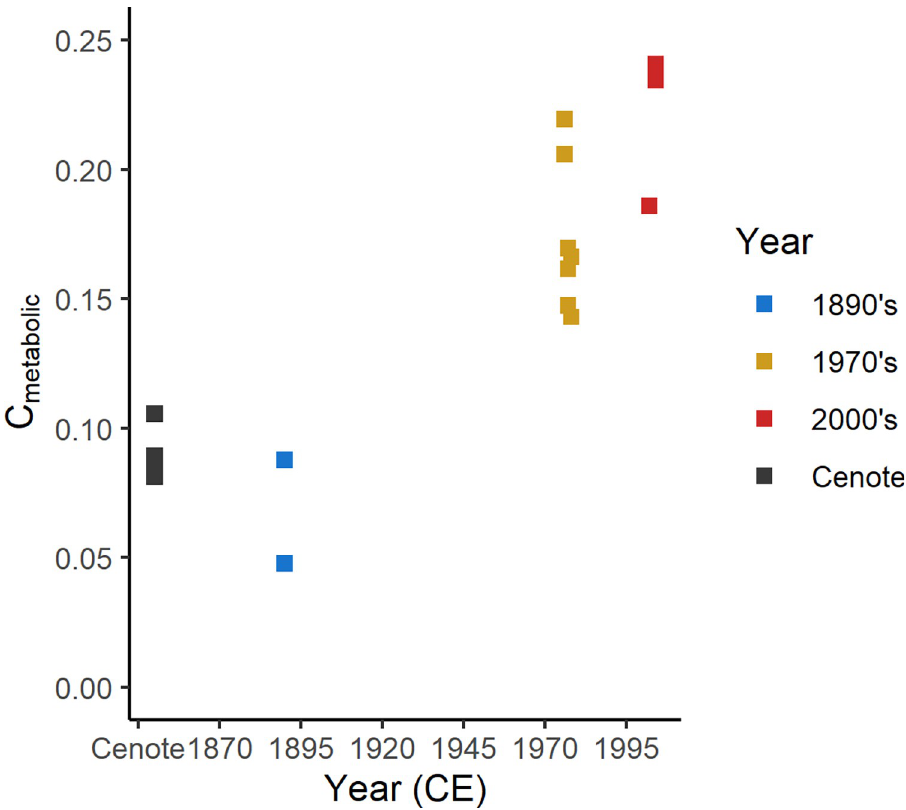
Fig 9. Crossplot of the calculated metabolic carbon contribution vs time. Note the increase in the amount of metabolic carbon incorporated into the shell since the 1970’s.